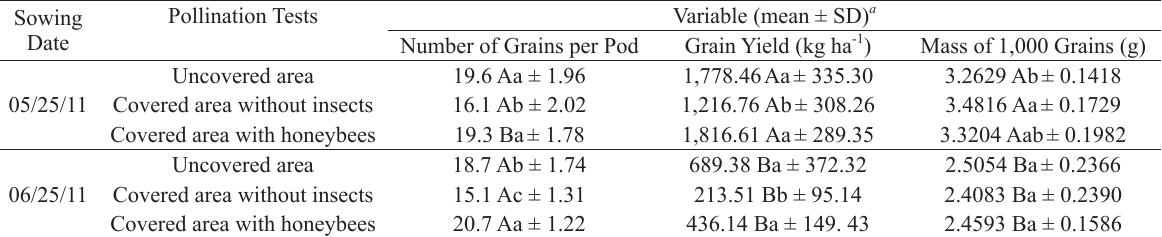
Mean and standard deviation values for the number of grains per pod, grain yield and mass of 1,000 grains per pollination test and sowing date combination in Marechal Cândido Rondon (state of Paraná,